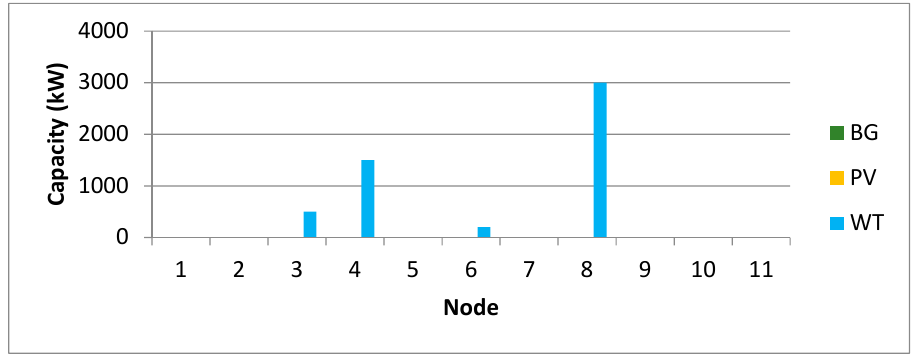
Figure A4. Capacity structure for 30% share of energy from RES in total demand with sizing and allocation of RES and energy storages (ES).